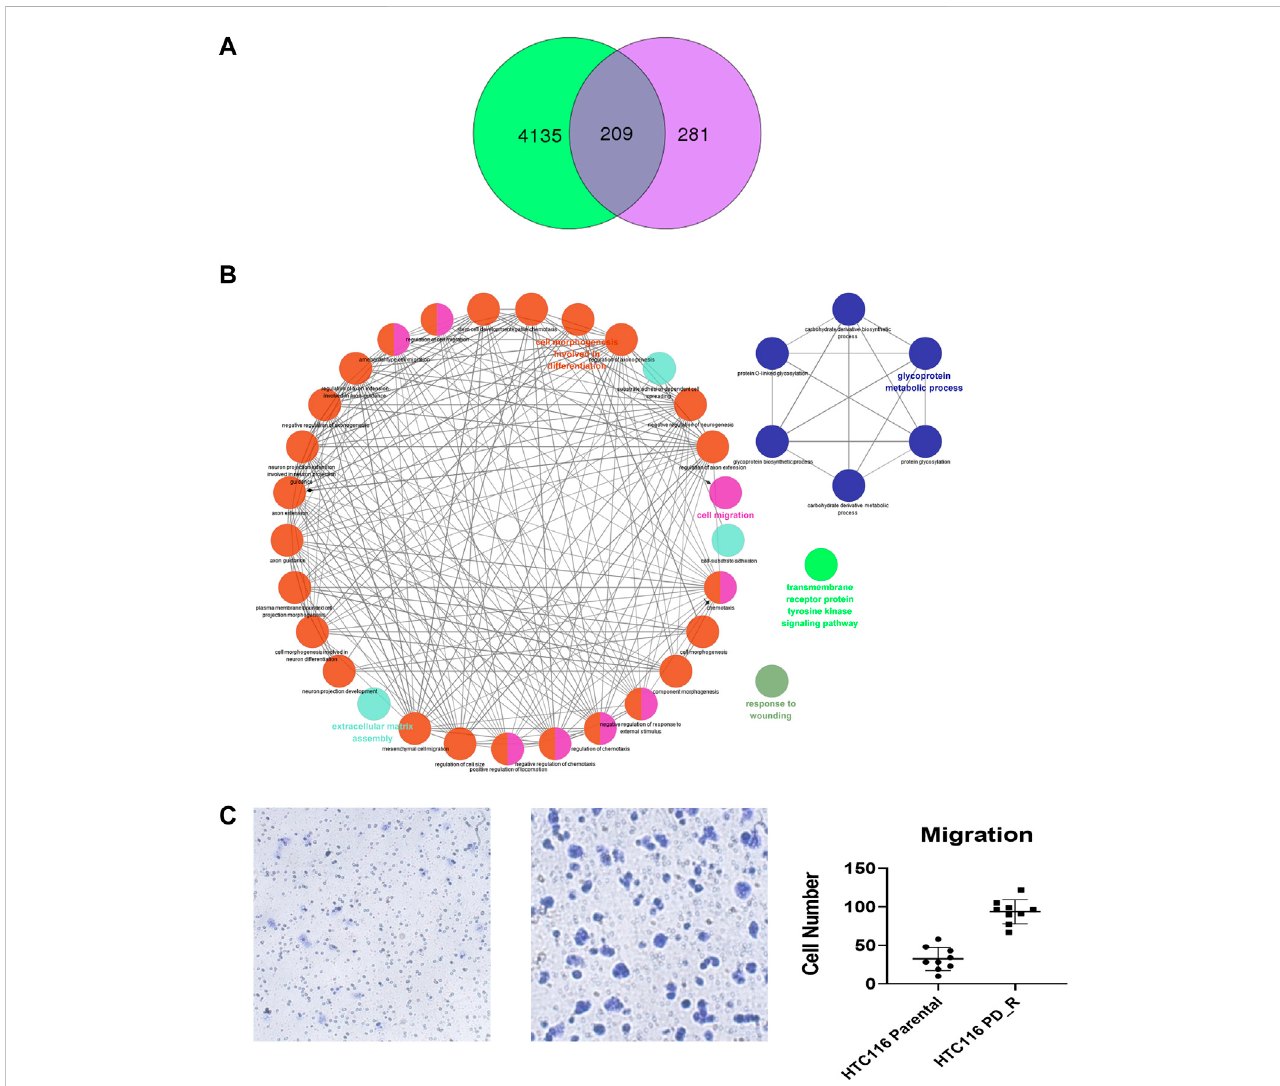
FIGURE 5 Exclusively identi fi ed N-glycoproteins in glycoproteomics analysis. (A) Venn diagram of proteins identi fi ed in proteomics or glycoproteomics, 281proteinswereexclusivelyidenti fi edinglycoproteomics.Green:Numberofproteinsidenti fi edbyproteomics;purple:numberofN-glycoproteinidenti fi ed by glycoproteomics; dark blue: number of proteins identi fi ed by both methods. (B) The biology process interaction network of 281 N-glycoproteins was constructed by the ClueGO app in Cytoscape software, based on GO data resource. For each module, the most signi fi cant pathway is highlighted by a colored name label. The size of the nodes indicates the number of identi fi ed proteins within this component. (C) Representative images of the transwell migration assay of HCT116 and HCT116 PD_R cells, and the quantitative number of migration